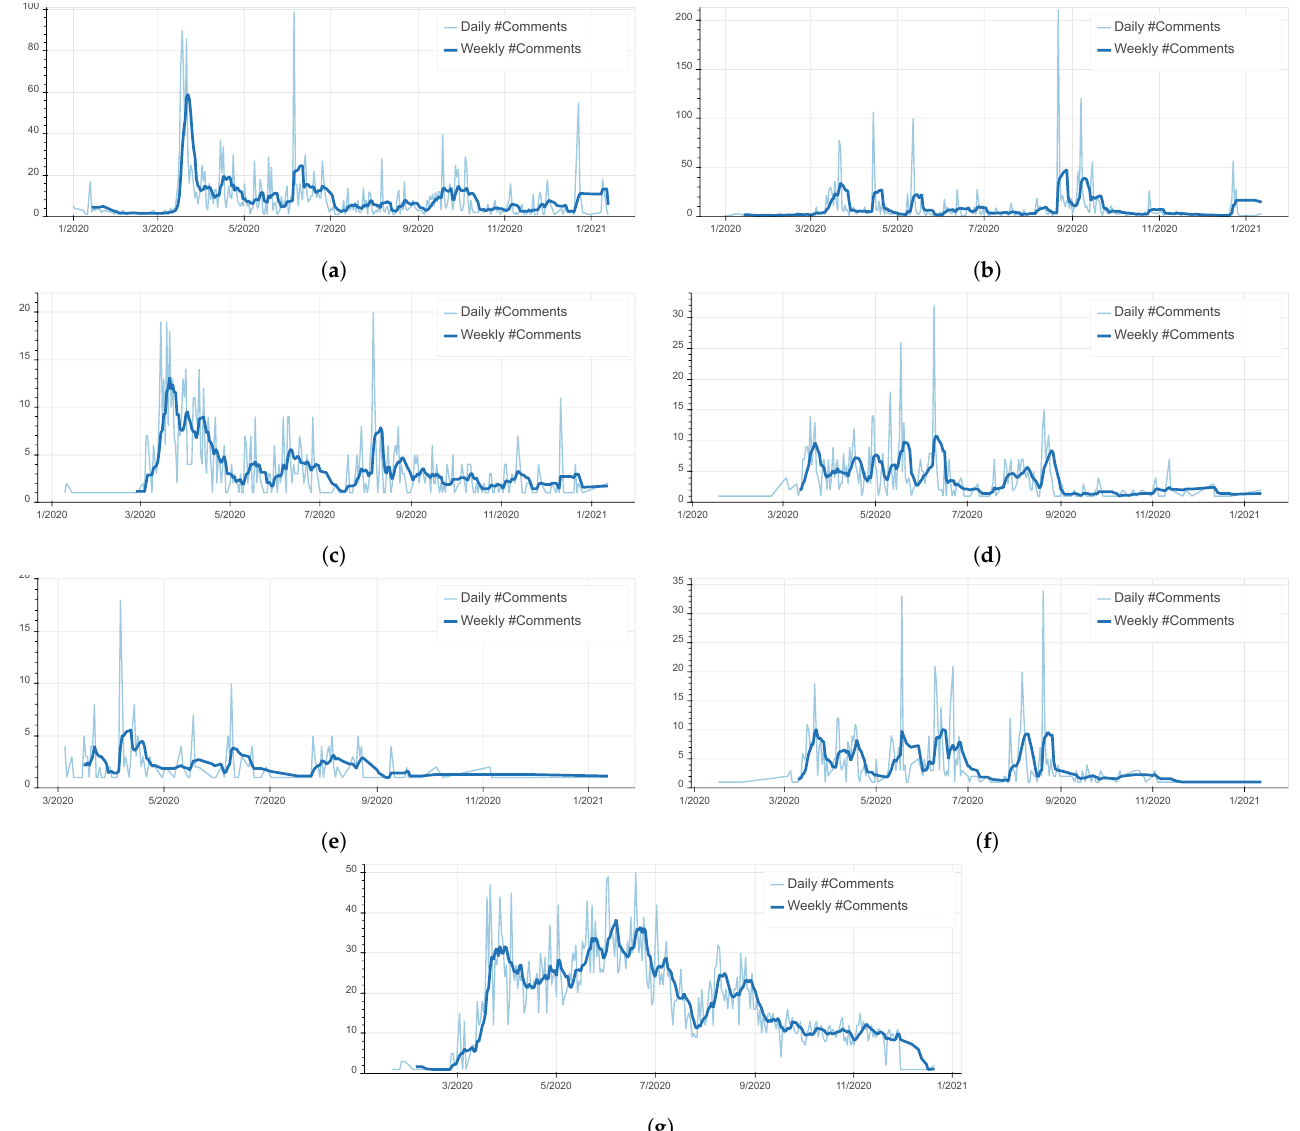
Figure 8. Evolution of topics in time (Number of comments/Time). ( a ) Evolution of ’Economy’ in time. ( b ) Evolution of ’Education’ in time. ( c ) Evolution of ’Health’ in time. ( d ) Evolution of ’Government’ in time. ( e ) Evolution of ’Sanitary Measures’ in time. ( f ) Evolution of ’Social Life’ in time. ( g ) Evolution of ’Statistics’ in